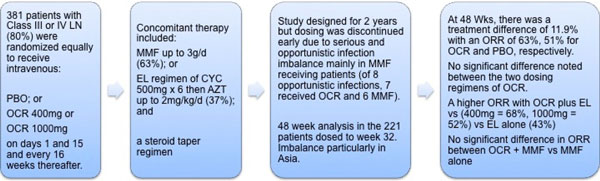
Treatment protocols of the EXPLORER and LUNAR studies. (a) EXPLORER
study. (b) LUNAR study. BILAG, British Isles Lupus Assessment Group;
ISN/RPS, International Society of Nephrology/Renal Pathology Society; MMF,
mycophenolate mofetil; MTX, methotrexate; Rx-AZA, treatment with azathioprine.